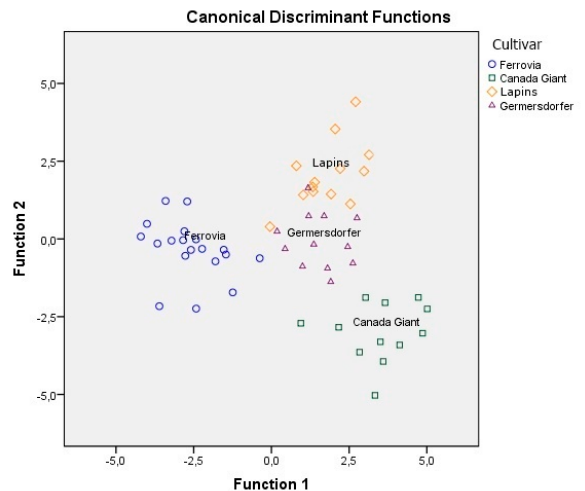
Figure 3. Di ff erentiation of four cultivars based on the combination of minerals, conventional quality parameters, and sugars.